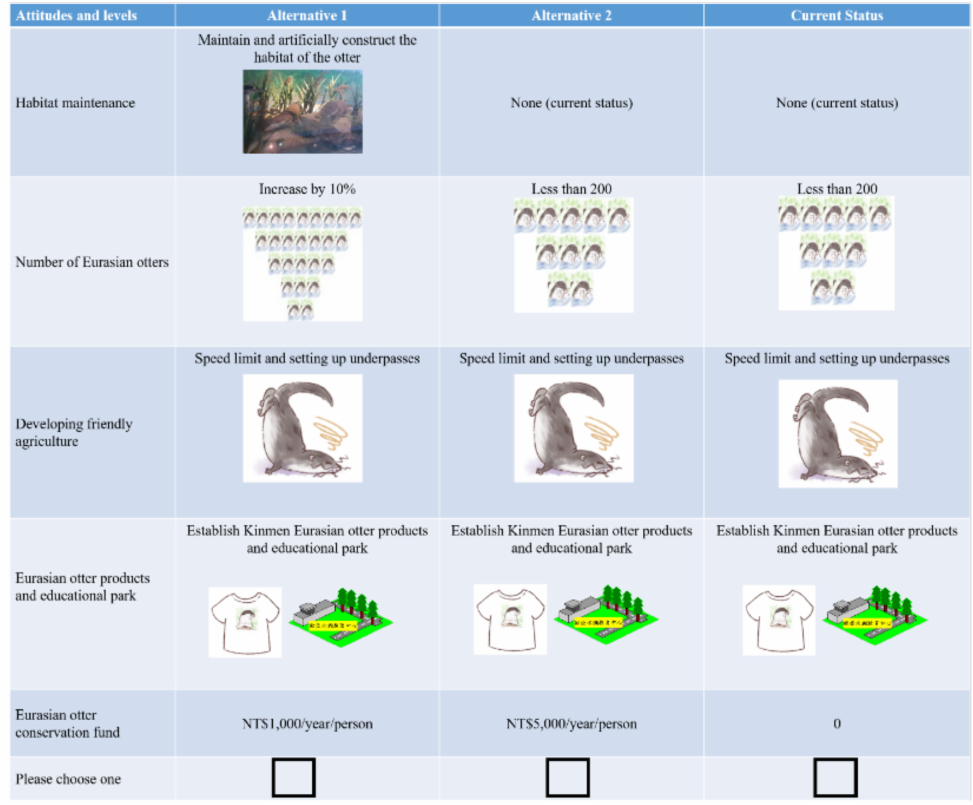
Figure 3. An example of a choice set for Kinmen Eurasian otter conservation